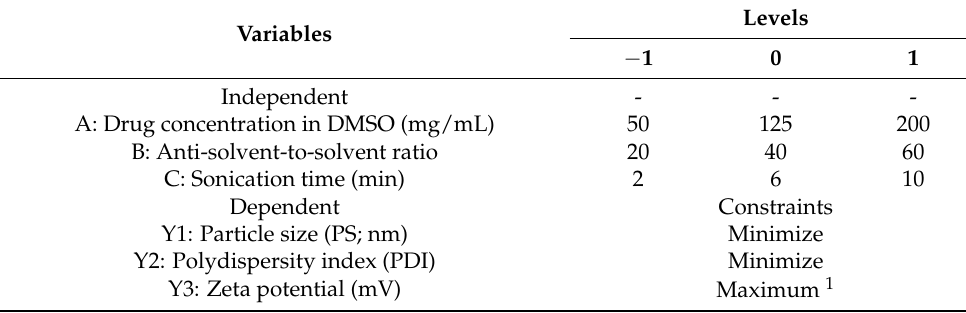
Table 2. The mathematical polynomial equation and the 3D surface plot were established, and the influence of formula variables on the response was analyzed. Table 1. Box–Behnken design used to optimize the preparation process Bre-NS. Variables